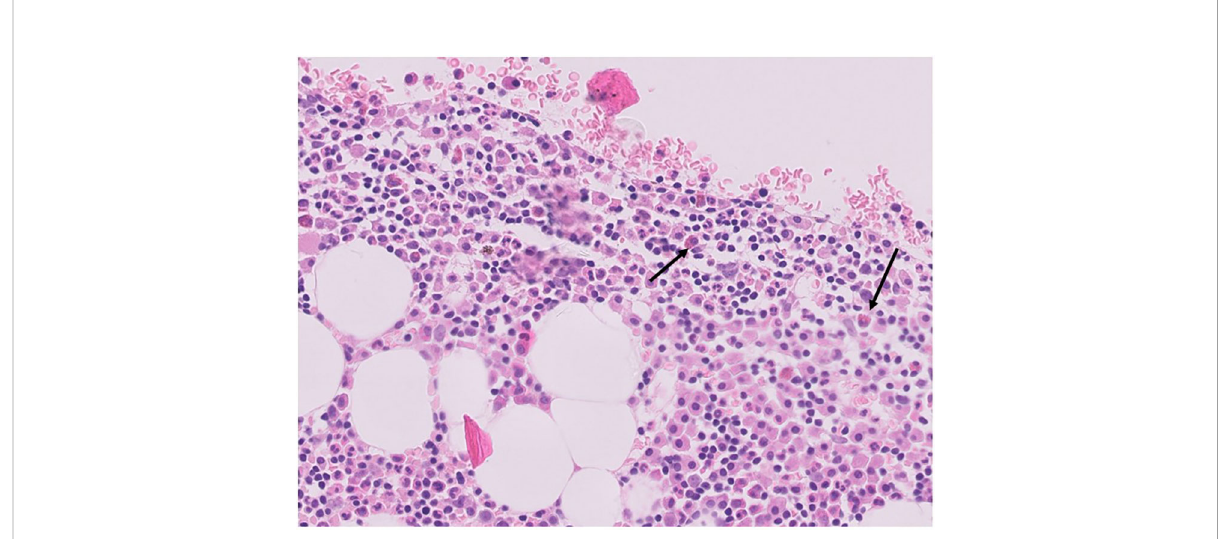
FIGURE 3 Hematoxylin & Eosin staining of mast cells (arrows) in a human CHL bioptic specimen (courtesy of professor Francesco Pezzella,